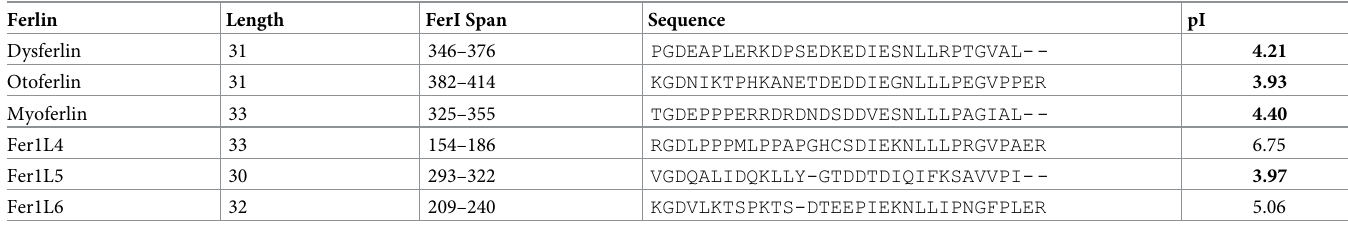
Table 1. Primary sequence alignment of the FerI region of the six human ferlin proteins.